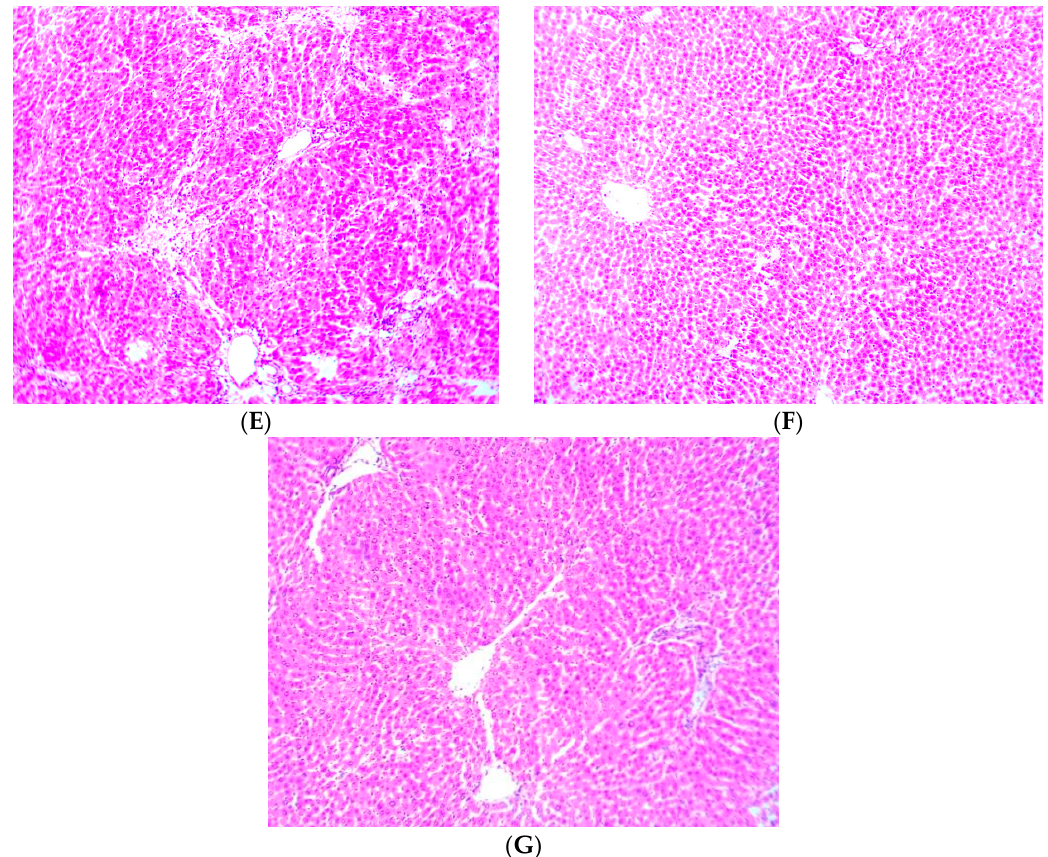
Figure 7. Histology showing control and experimental groups. Group ( A ); Served as the control animals ( B ); Animals receiving NDEA (200 mg/kg) ( C ); Animals receiving NDEA + Cajanus cajan (200 mg/kg) ( D ); Animals receiving NDEA + Cajanus cajan (400 mg/kg) ( E ); Animals receiving NDEA + Cajanus cajan (800 mg/kg) ( F ) Animals receiving NDEA + Silymarin (50 mg/kg) ( G ) Animals receiving Cajanus cajan (800 mg/kg) only.